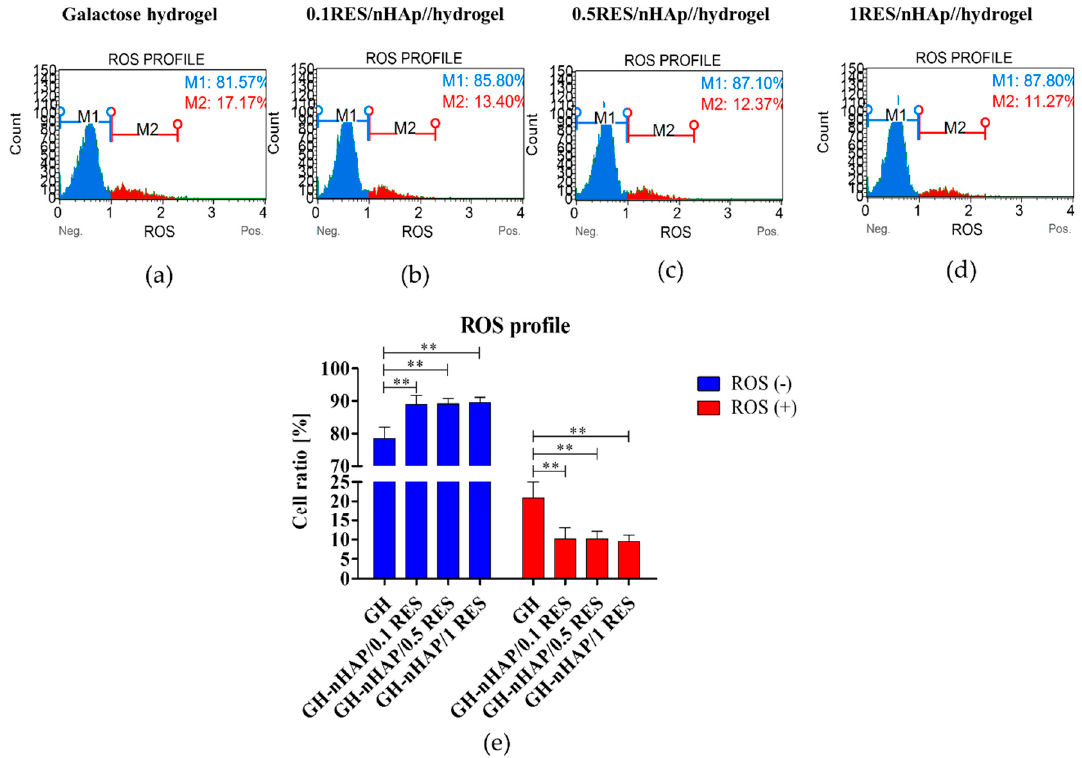
Figure 10. The results of analysis of reactive oxygen species (ROS) accumulation in hASC cultured on tested hydrogels. The representative histograms ( a – d ) showing the distribution of cells into two populations—cells not showing activity or ROS, and cells accumulating ROS. M1 refers to the ROS-negative population of cells and M2 indicates ROS-positive cells. The comparative analysis was performed ( e ) and statistically significant changes are indicated with asterisks (**) p < 0.01.